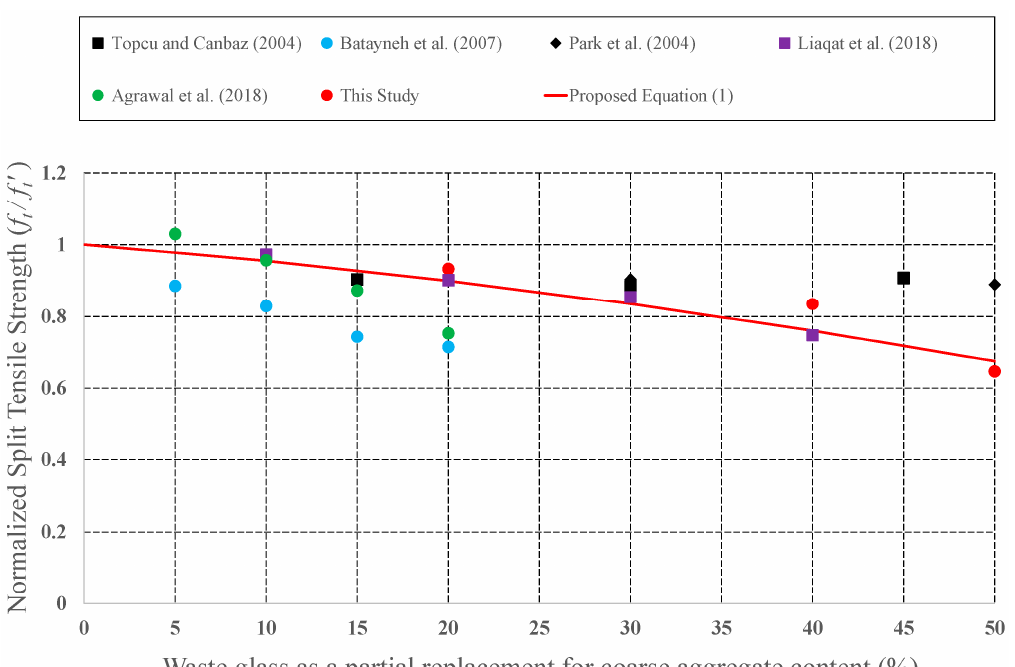
Figure 9. Discrepancy of the regulated STS of the concrete formed with CWG as a partial replacement for CA [40,46,47,60,79].